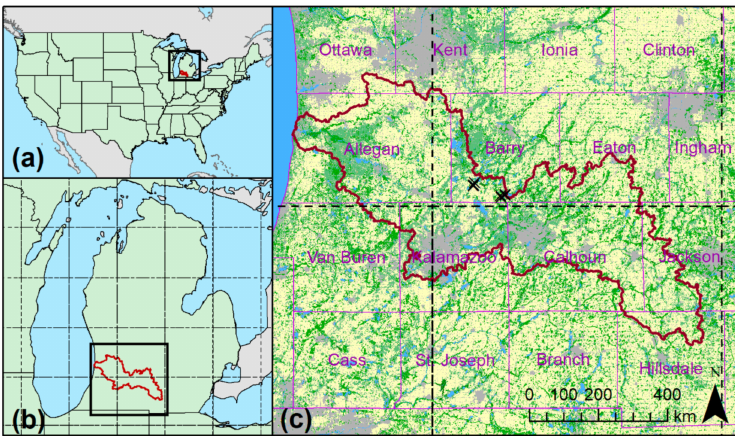
Figure 1. Southwestern Michigan study location—Kalamazoo watershed (KW) outline in red in all panels. ( a ) Map of the contiguous United States showing location of lower Michigan, with black box indicating the boundary of the map in B. ( b ) Map of lower Michigan with boundary for map A shown in the black box. Dashed lines indicate boundaries of Community Land Model (CLM) grid cells in B and C. ( c ) Local map of the KW with counties in purple with a simplified National Land Cover Database (NLCD) 2011 land cover map as background: gray is developed, yellow is cultivated, light green is forest, darker green is wetland, blue is water. Flux tower locations in southern Barry County are marked with a black